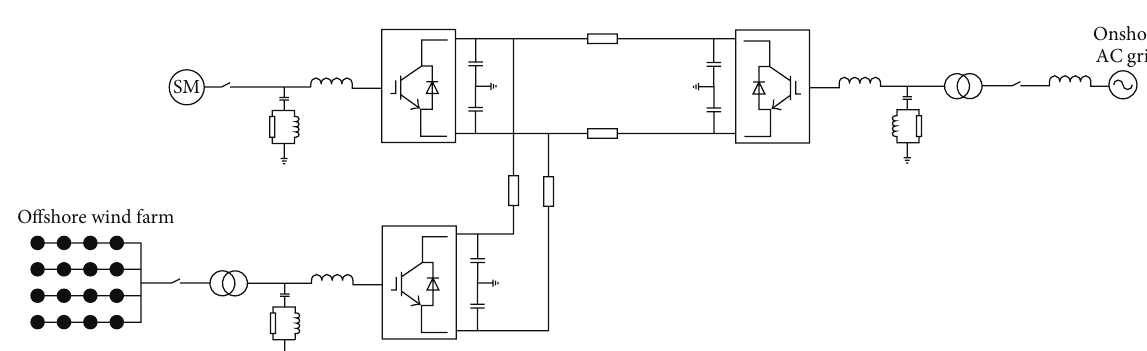
Figure 5: Illustration of 1000MW case.